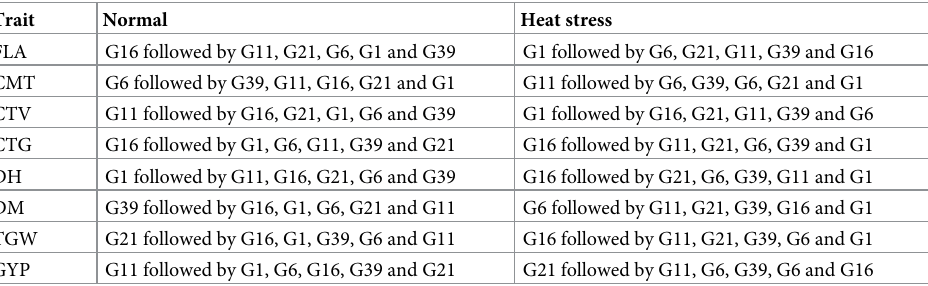
Table 2. Best performance wheat genotypes in normal and heat stress condition based on averaged data over year.